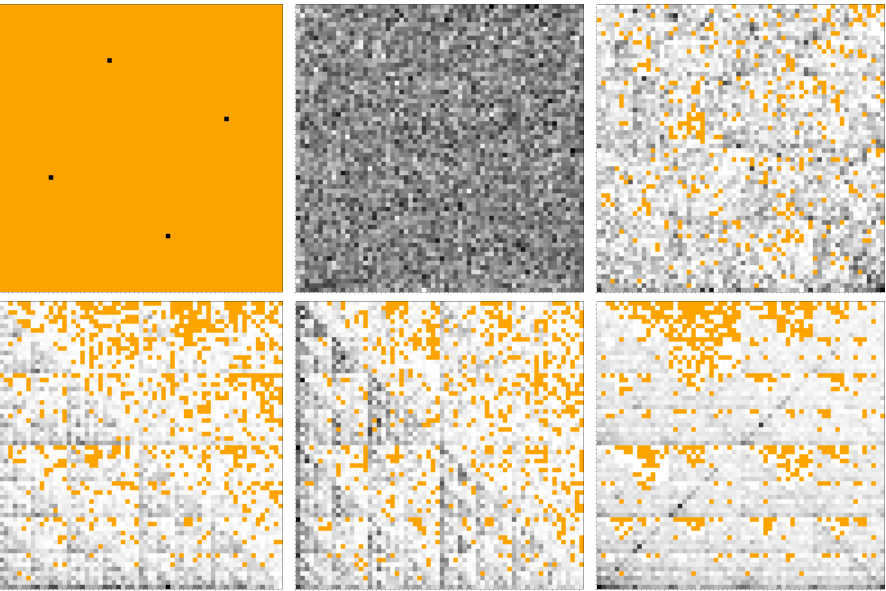
Figure 7. FCGR of DNA sequences at k = 6. ( Upper left ) Periodic DNA. ( Upper middle ) Random DNA. ( Upper right ) E. coli . ( Lower left ) M. mitochondrion. ( Lower middle ) H. sapiens . ( Lower right ) H. cosmid